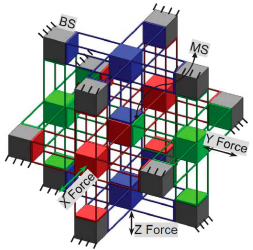
Figure 5. A fully symmetric design, obtained by adding three redundant legs to the XYZ CPM shown in Figure